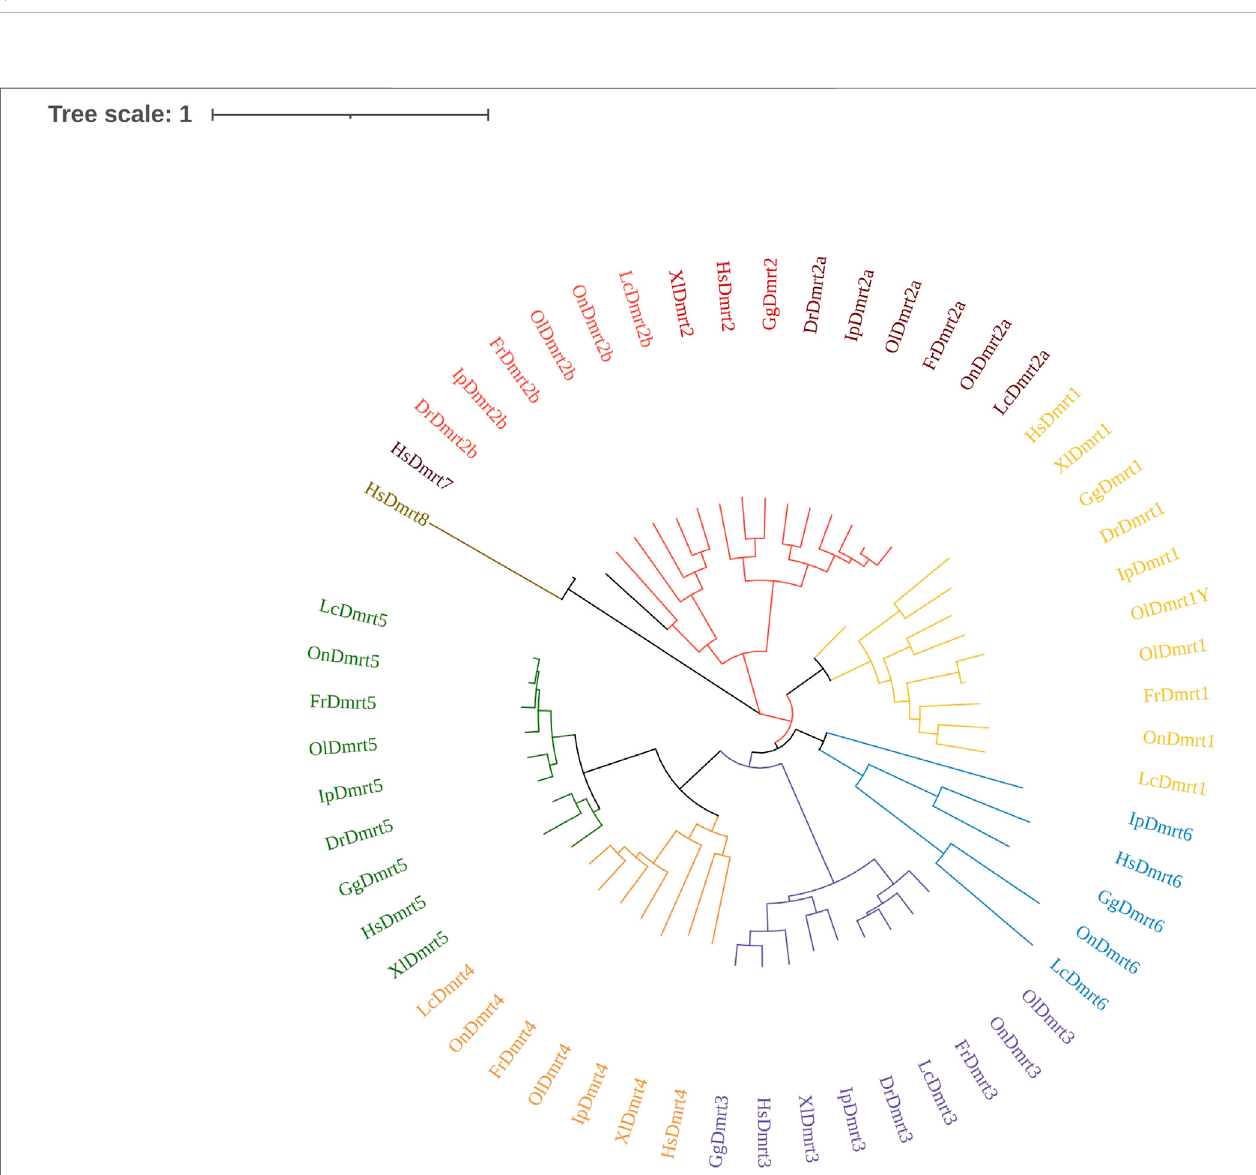
FIGURE 3 | Phylogenetic tree analysis of Dmrt gene family members from human, chicken, African clawed frog, zebra fi sh, large yellow croaker, Nile tilapia, Japanesepuffer fi sh,andchannelcat fi sh.ThephylogenetictreewasconstructedinMEGA7,usingtheneighbor-joiningmethod.TheGenBankaccessionnumbersofthe sequences used are listed in the Supplementary Table S1